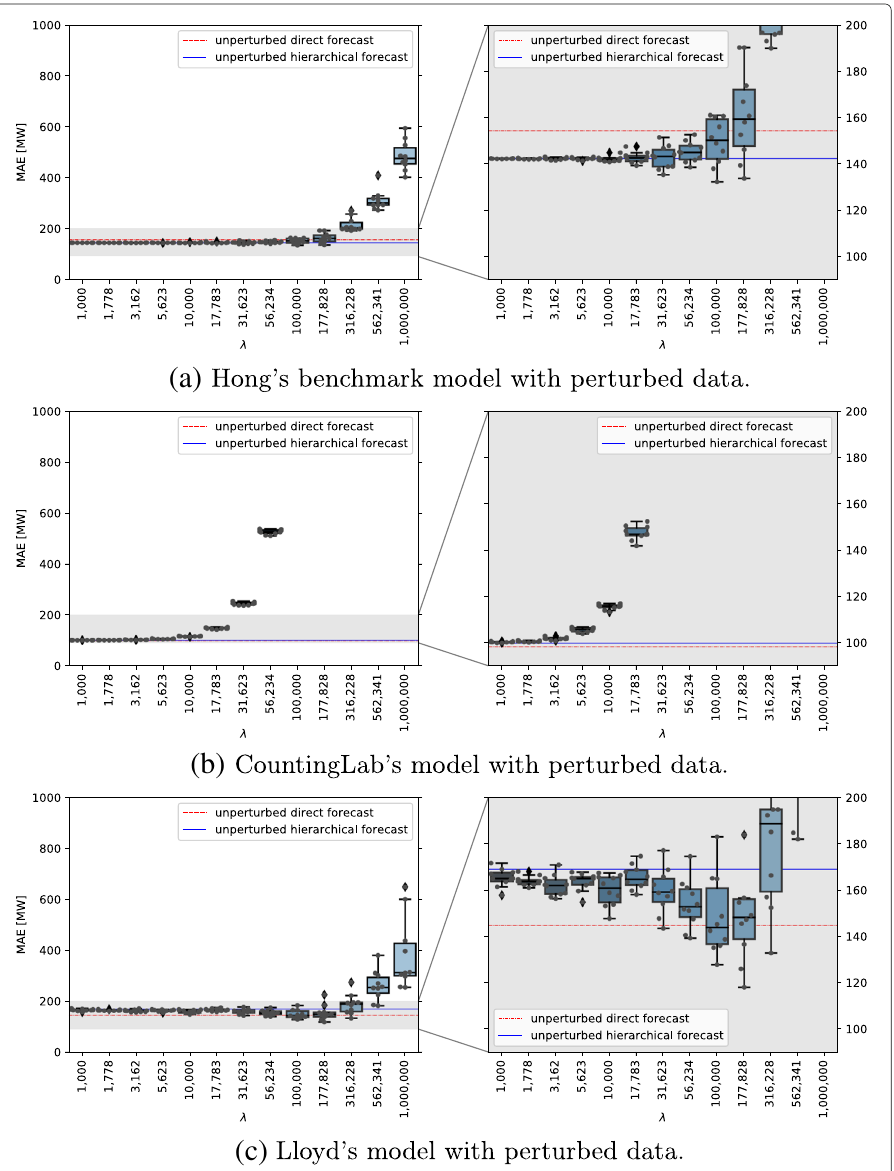
Fig. 4 Forecasting errors (MAE) of the forecasting models with increasing levels of noise. Blue, solid lines: MAE of the hierarchical models, each without noise. Red, dashed lines: MAE of direct forecast models. a , Hong’s benchmark model with peturbed data. b , CountingLab’s model with peturbed data. c , Lloyd’s model with peturbed data